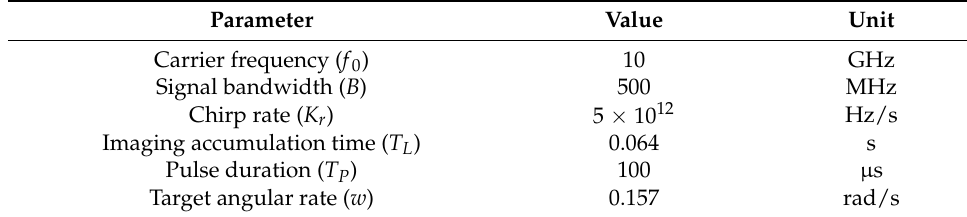
Figure 5. The simulation result of the Yak-42 aircraft. ( a ) Multiple scattering points model. ( b ) Original image. Table 1. Simulation